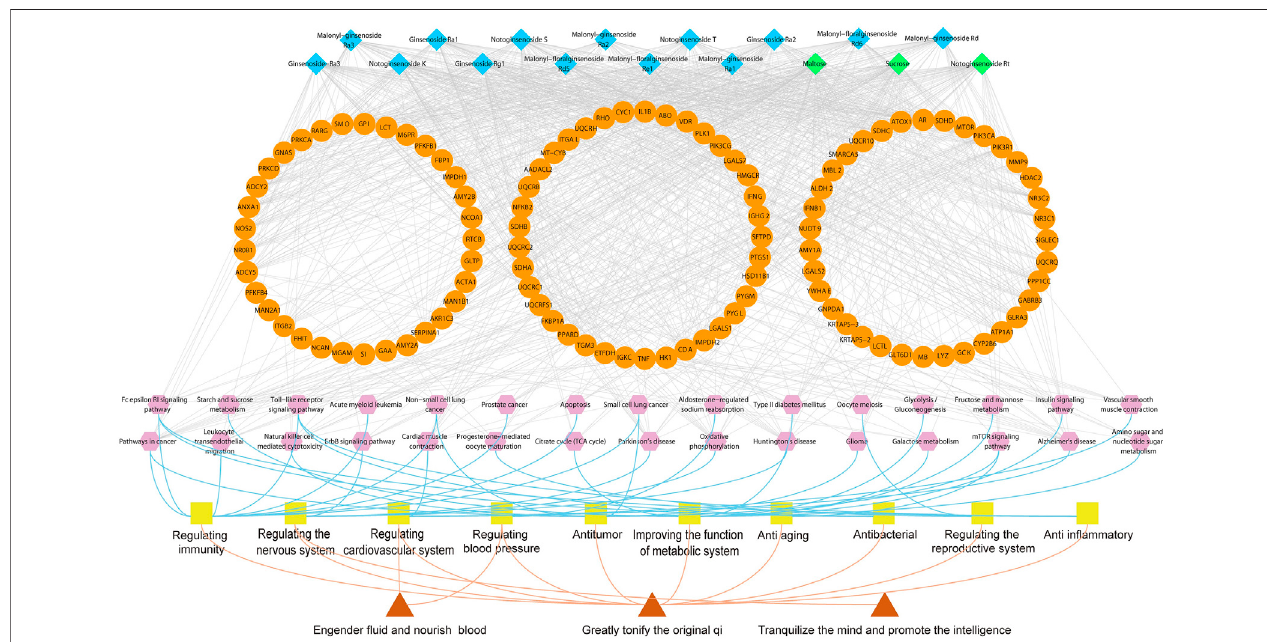
FIGURE 5 | Illustration of the relevance among marker compounds for distinguishing MCG and GG, their target, pathways and therapeutic effects. Blue nodes represent characteristic constituents of MCG. Green nodes represent characteristic constituents of GG. Orange nodes refer to the targets; Purple nodes represent the pathways; Yellow nodes refer to therapeutic effects. Red nodes represent the effect of ginseng.